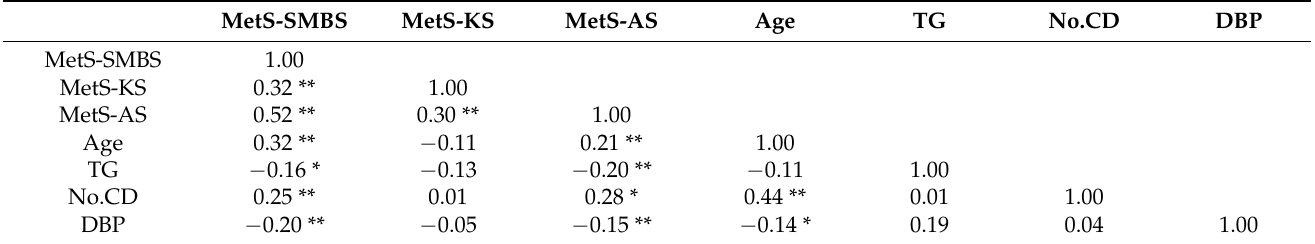
Table 4. Correlation between MetS self-management behavior and its variables (n = 231).